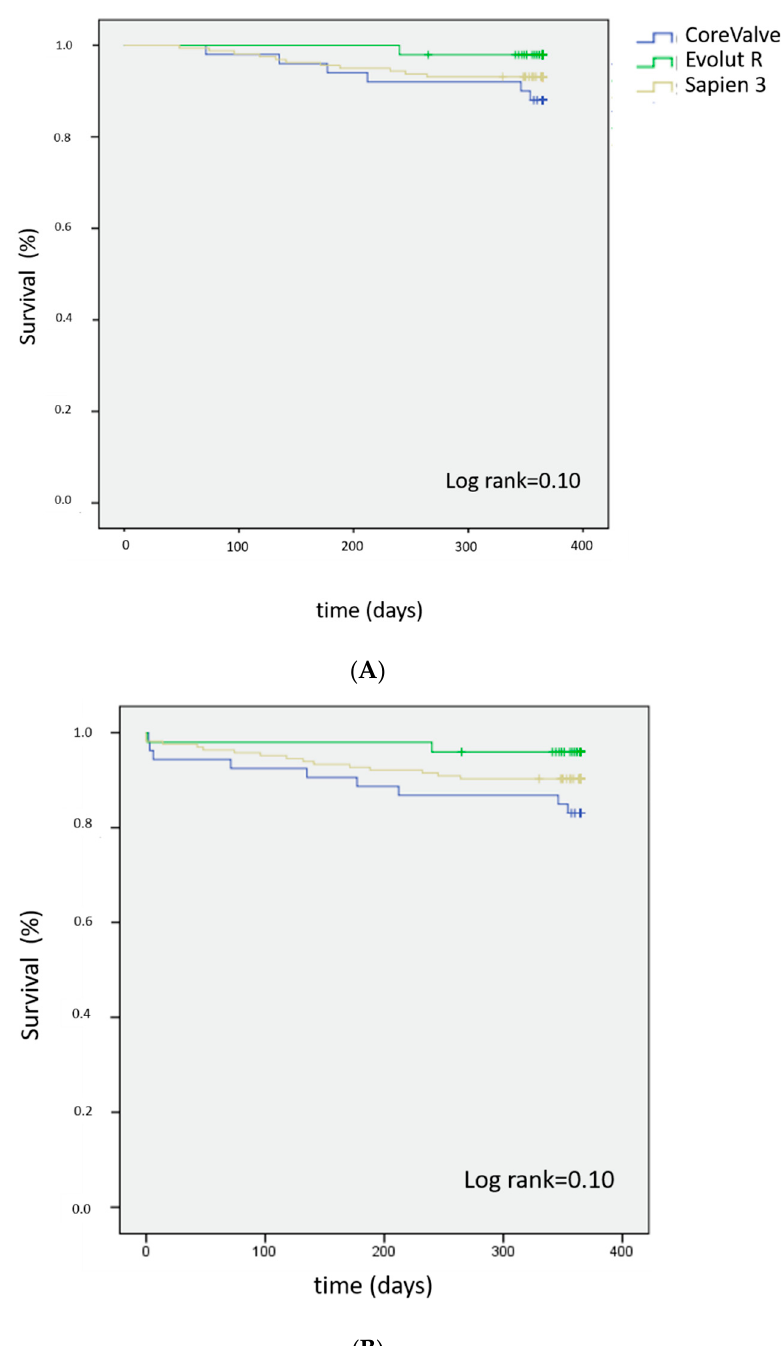
Figure 3. Kaplan–Meier plots of overall mortality in the intention-to-treat (panel ( A )) and per-protocol (panel ( B )) populations observed from hospital discharge to 1-year follow-up in patients implanted with the Sapien S3 ® , CoreValve ® , and Evolut ® R prostheses.